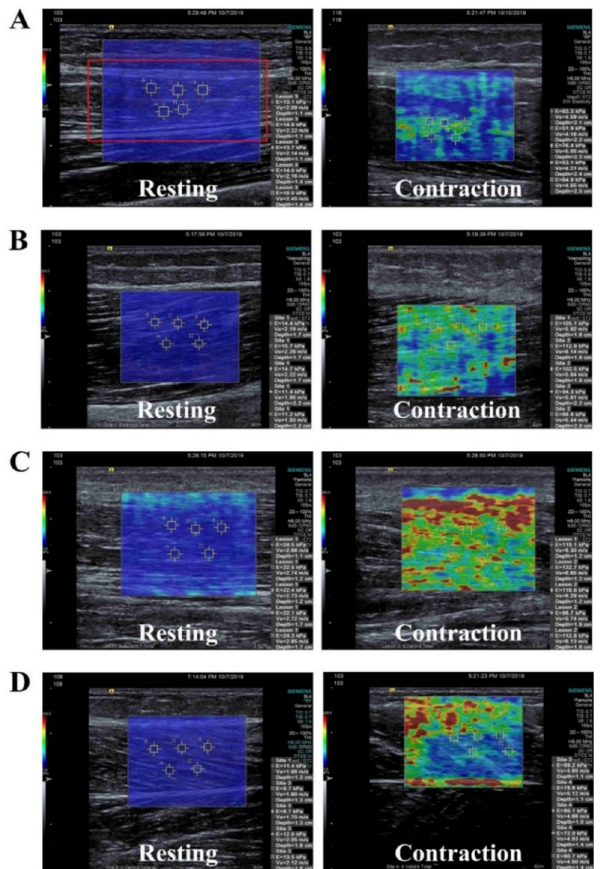
Figure 2. Shear-wave elastography images for measurements of ( A ) rectus femoris, ( B ) biceps femoris, ( C ) tibialis anterior, and ( D ) medial gastrocnemius at rest and during active voluntary